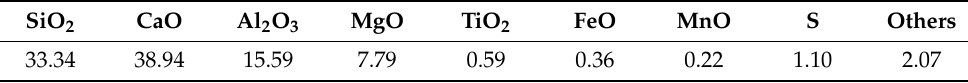
Table 2. Chemical composition of the slag,